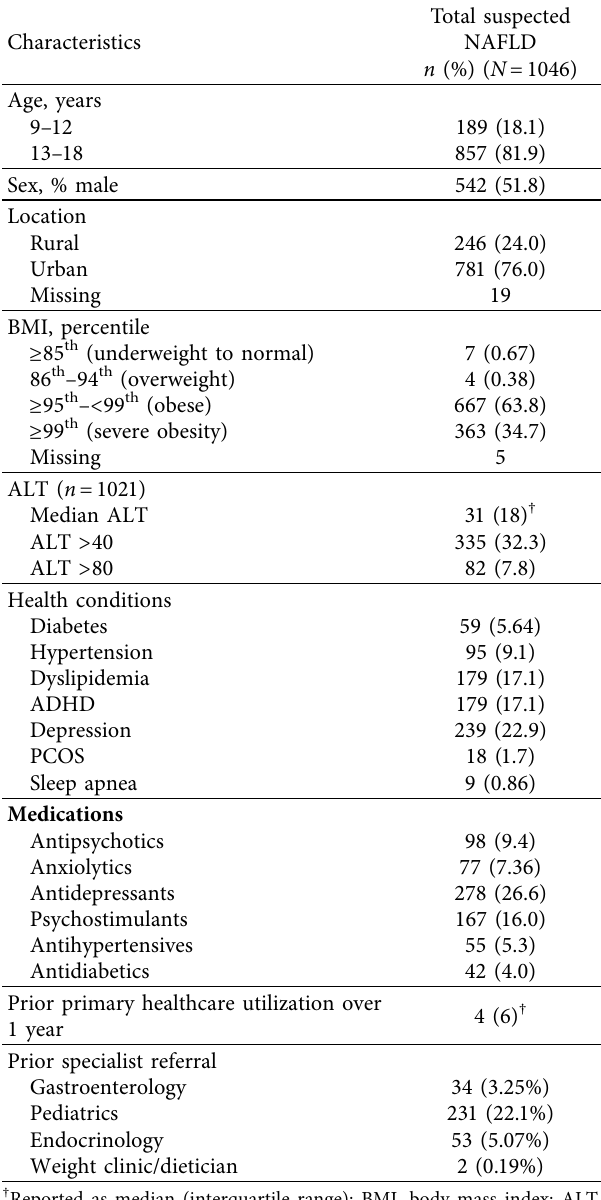
Table 3: Patients with suspected NAFLD.